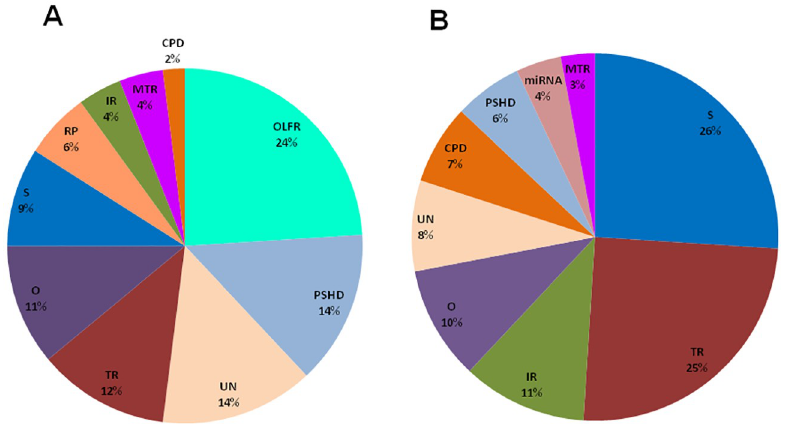
Fig 3. Distribution of ouabain-sensitive genes detected in cerebellum granule cells and listed in Tables 4–7 among major functional categories. Cells were incubated in the presence of 100 nM ( A ) or 1 mM ouabain ( B ) for 3 h. Functional categories: CPD—cell proliferation and death; IR—immune and inflammatory responses; miRNA— microRNAs; MTR—membrane transporters; O—others; OLFR—olfactory receptors; PSHD—protein, synthesis, holding, and degradation; RP—ribosomal proteins; S—signaling; TR—transcription regulation; UN—uncharacterized.